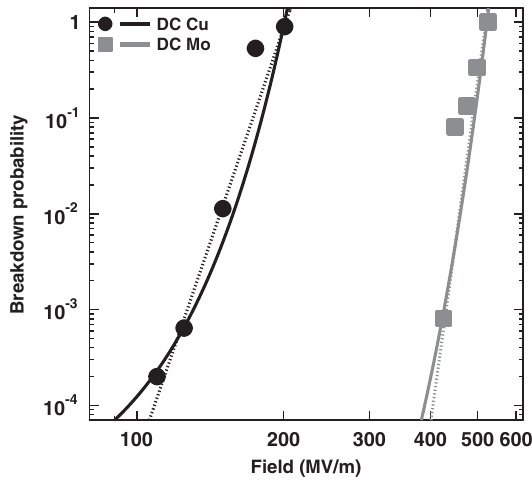
FIG. 1. Measured dependences of R the dc breakdown measurement setup at CERN [21] and fits of our model (solid lines) as well as power laws (dashed lines) to the data.